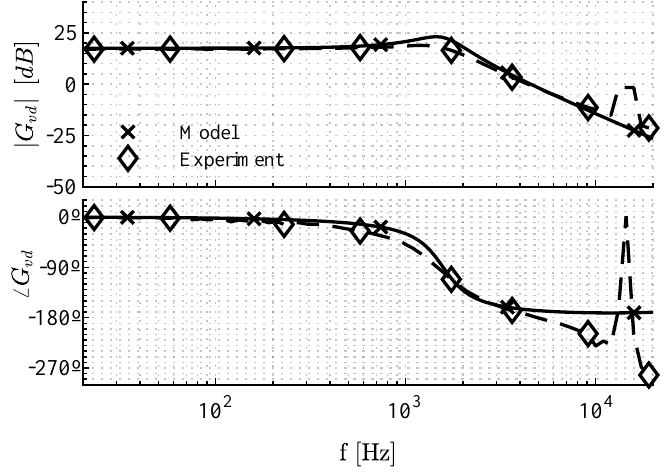
Figure 11. Bode plot comparison of control-to-output transfer function from the small-signal model and experimental test bed.